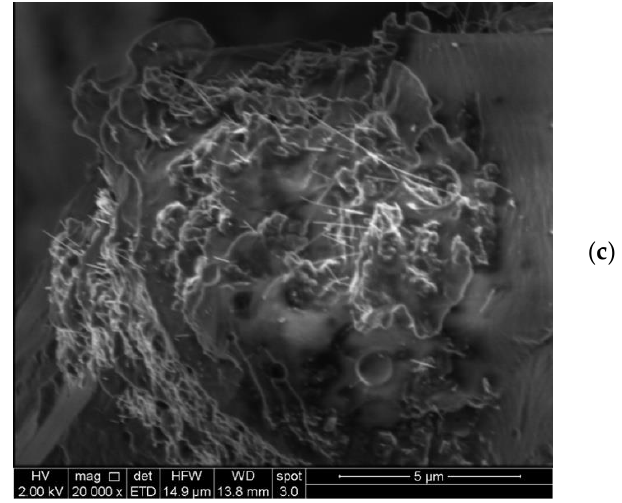
Figure 4. SEM morphological study of PK30PEA ( a ), PK30TMA ( b ), and PK30PMA ( c ) nanocomposites containing 8 wt % MWCNTs.